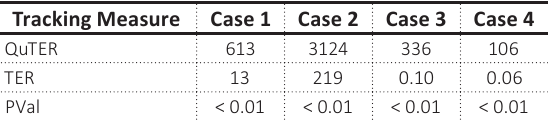
Table 2. Sensitivity of TER and QuTER